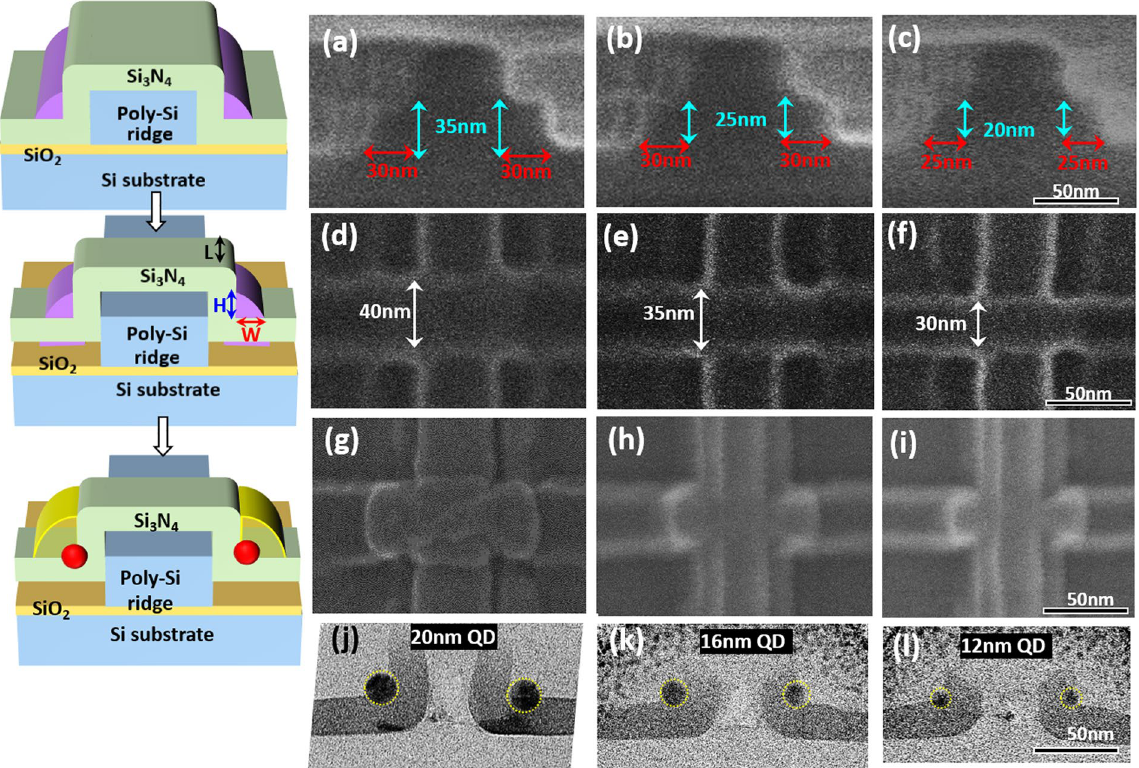
Figure 3. A pair of Ge DQDs simultaneously fabricated by the thermal oxidation of poly-SiGe spacer islands nanopatterned over Si 3 N 4 layers encapsulating poly-Si ridges. 12 nm–20 nm Ge DQDs are produced by controlling the width (25–30 nm), height (20–35 nm), and length (30–40 nm) of the poly-SiGe spacer islands by varying the process times for poly-SiGe deposition and etch back in combination with the exposure dose of electron-beam lithography. Cross-sectional SEM micrographs of poly-SiGe spacer layers with Widths/ Heights (W/H) of ( a ) 30 nm/35 nm, ( b ) 30 nm/25 nm, and ( c ) 25 nm/20 nm produced by using SF 6 /C 4 F 8 plasma etch-back with process times of 7 sec, 9 sec, and 10 sec, respectively. Plan-view SEM micrographs of e-beam lithographically-patterned poly-SiGe spacer islands with lengths of ( d ) 40 nm, ( e ) 35 nm, and ( f ) 30 nm produced by exposure electron doses of 4.8 × 10 − 16 C, 5.4 × 10 − 16 C and 6.0 × 10 − 16 C, respectively. Following thermal oxidation at 900 °C for 10.5 min, plan-view SEM/cross-sectional TEM micrographs of ( g , j ) 20 nm, ( h , k ) 16 nm and ( i , l ) 12 nm diameter Ge QDs are produced by controlling the widths (25–30 nm), heights (25– 35 nm), and lengths (30–40 nm) of the poly-SiGe spacer islands by varying the process times of poly-SiGe etch back and E-beam exposure. Inset on the left shows the corresponding structure schematic diagrams for